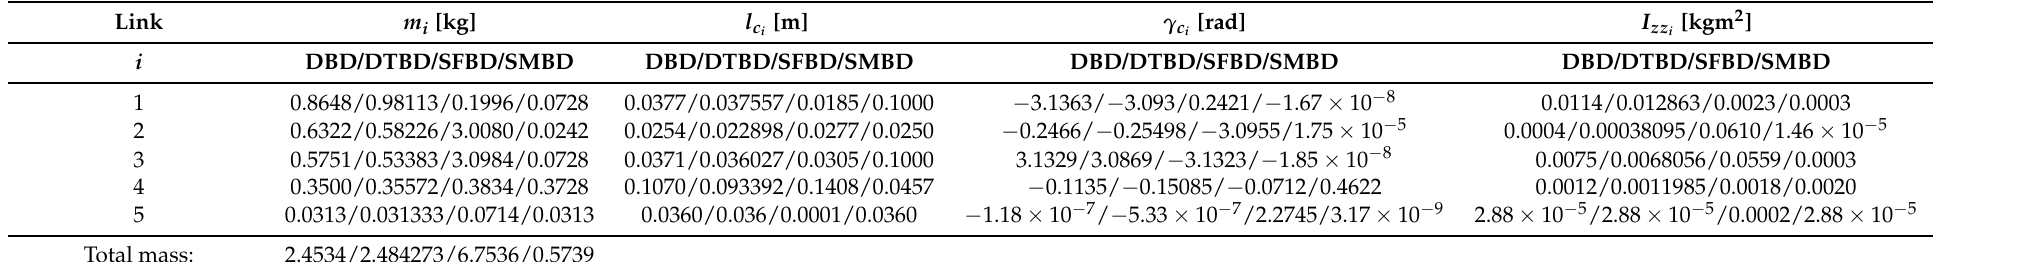
The boldface number indicates the best performance (minimum value) between the DBD and RBD. Table 7. Dynamic parameters of the DBD, the DTBD, the SFBD, and the